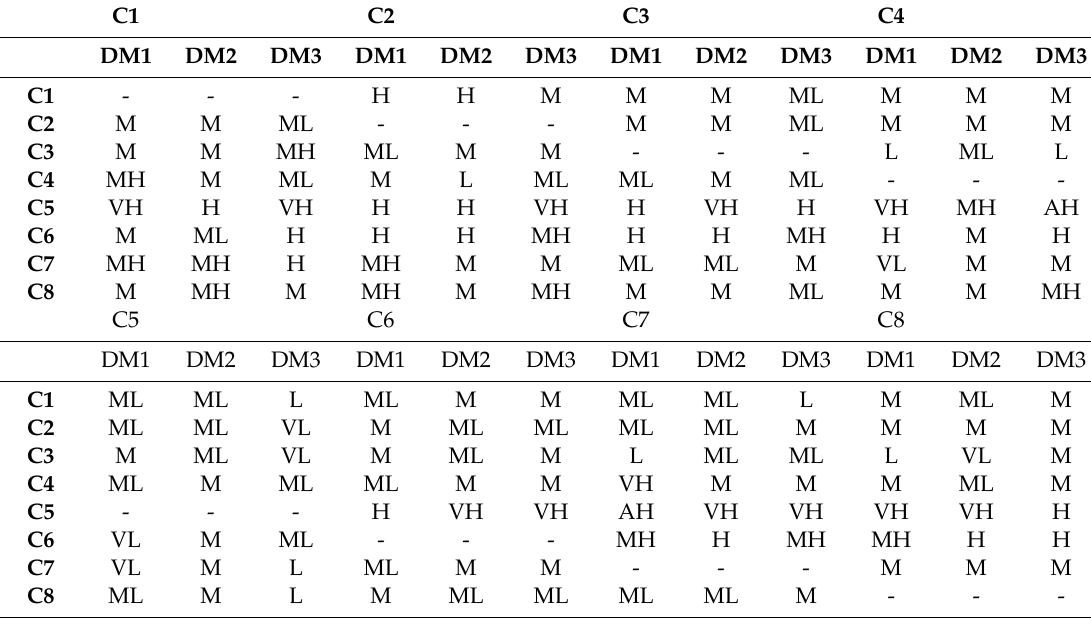
Table 3. Linguistic Evaluations of Decision Makers for Criteria.